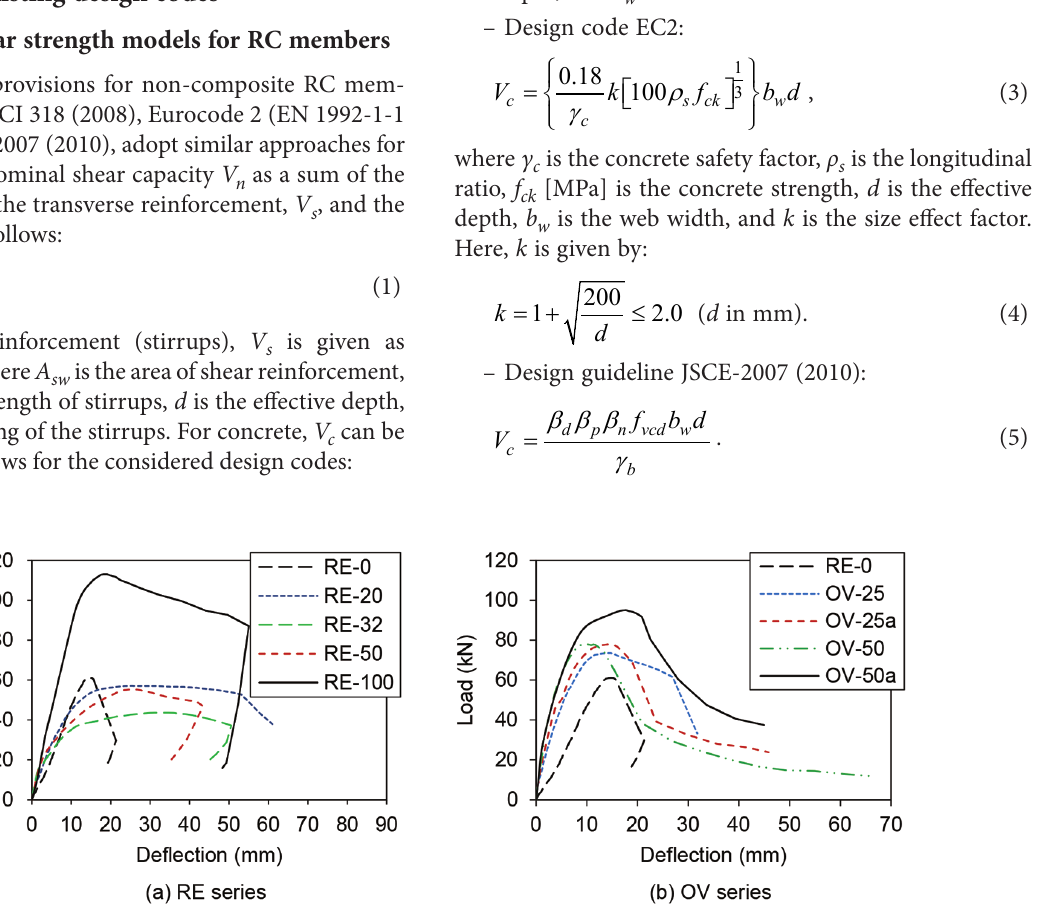
Figure 3. Load–deflection curves of the test specimens (Yin et al.